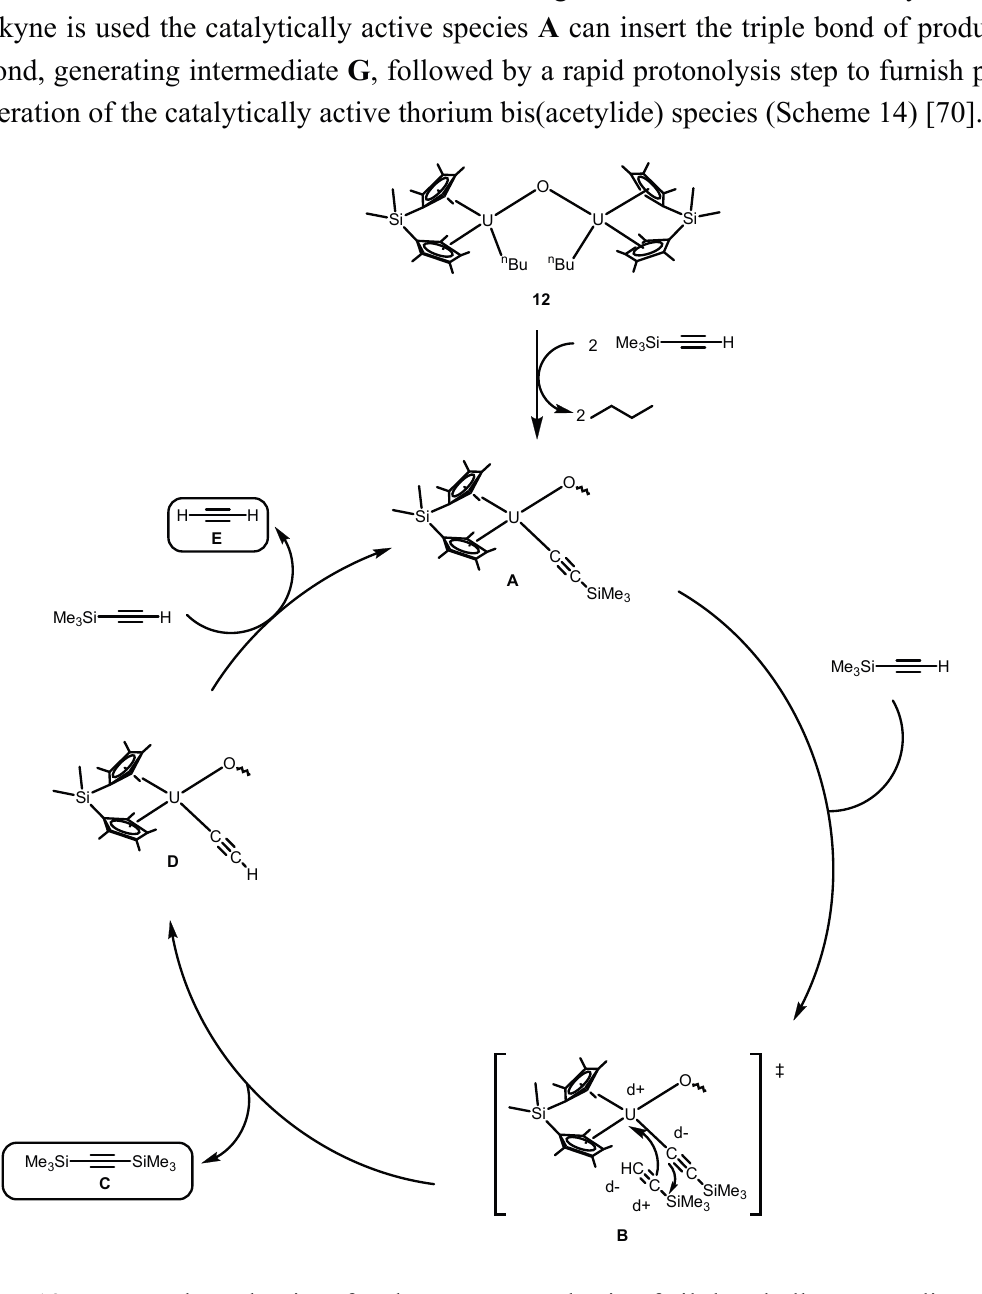
Scheme 13. Proposed mechanism for the cross metathesis of silylated alkynes mediated by complex 12 . A symmetric half of complex 12 has been omitted for clarity. Adapted